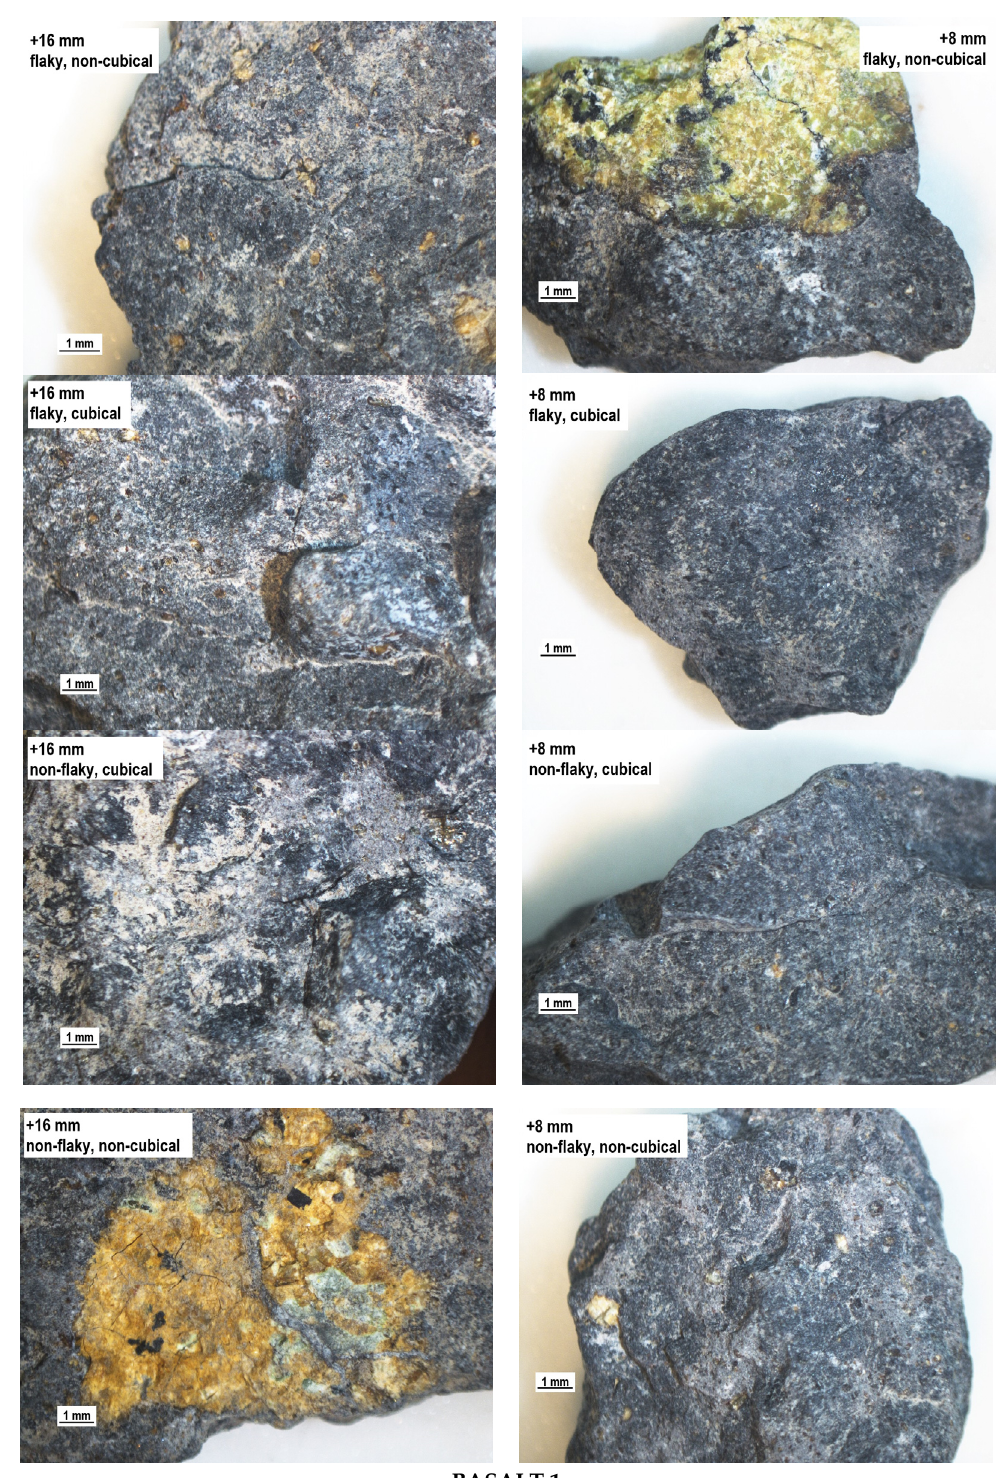
Figure 7. The structure of the particles of the basalt 1 aggregate, separate for the shape and particle size. Similar as in the case of the basalt 2 aggregate (Figure 8) for the +16 mm fraction, fractures occur more frequently in the non-cubical particles than in the cubical particles. In addition, structures of internal fracture lines are clearly visible in the phenocrysts. In the case of fine particles (below 16 mm), fractures are found mainly in the structure of the phenocrysts or on the boundary between the phenocrysts and the background. Fractures are rarely observed in cubical particles.